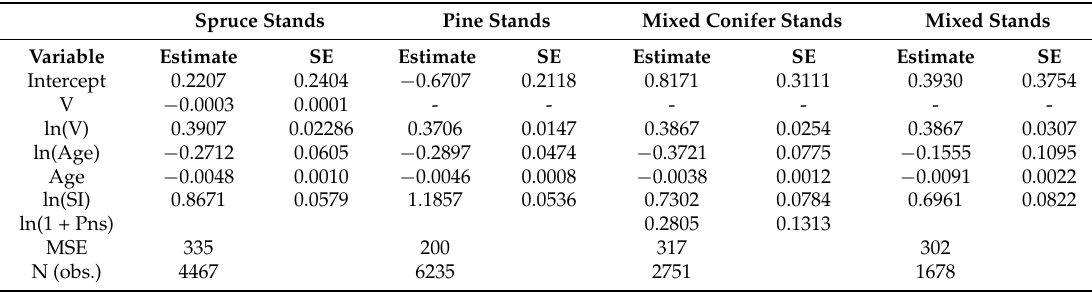
Table A2a. Coefficients for the net volume growth (V i , 5 years) functions.